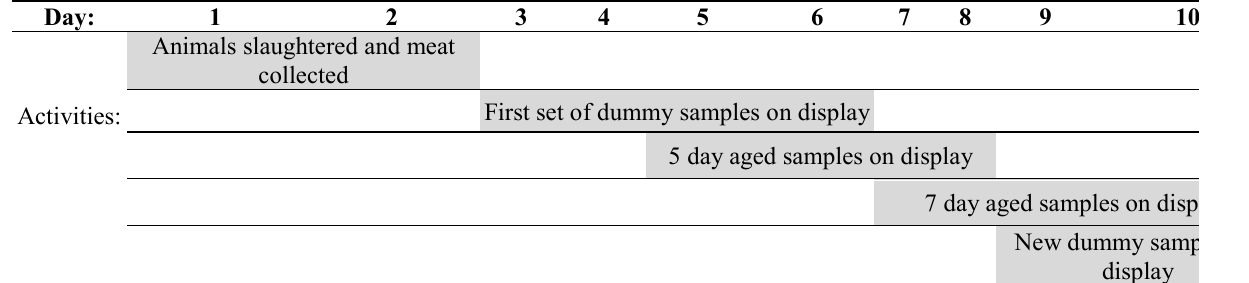
Figure 1. An example of loin and topside sample allocation to different storage periods for the two different groups of carcasses.